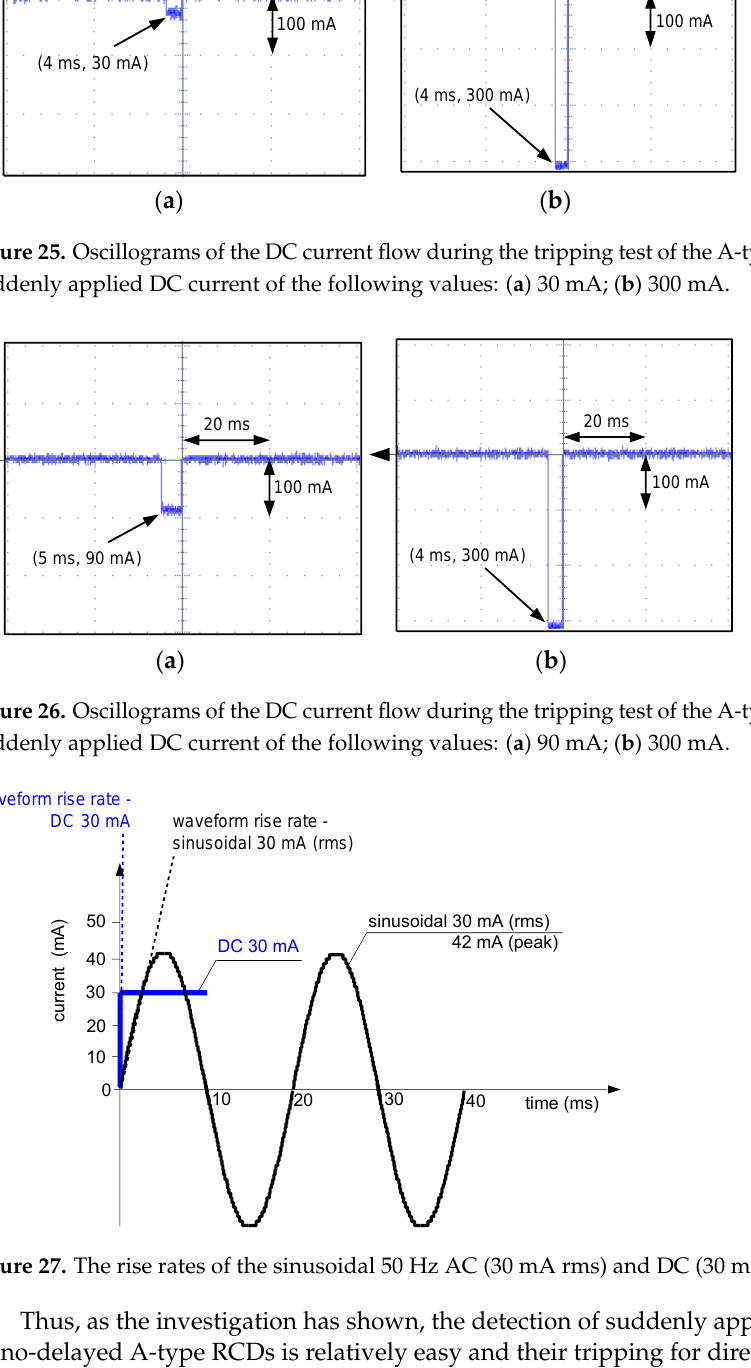
Figure 24. Oscillograms of the DC current flow during the tripping test of the A-type RCD (RCD30_7). Suddenly applied DC current of the following values: ( a ) 60 mA; ( b ) 300 mA.